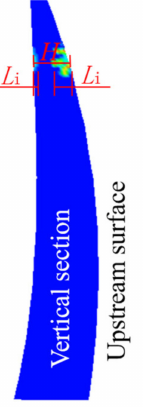
Figure 2. Parameters of local damage to the middle part of the dam.